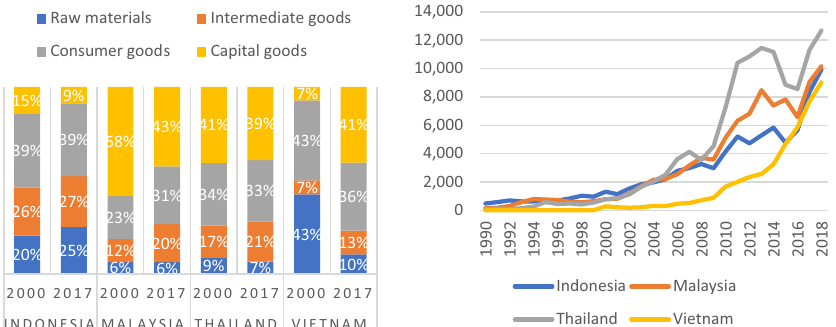
Fig. 5 Selected ASEAN countries export compositions and their intermediate goods export to China. Note to the right graph: Value of intermediate goods export to China, in million US$. Source: www. wits. world bank.